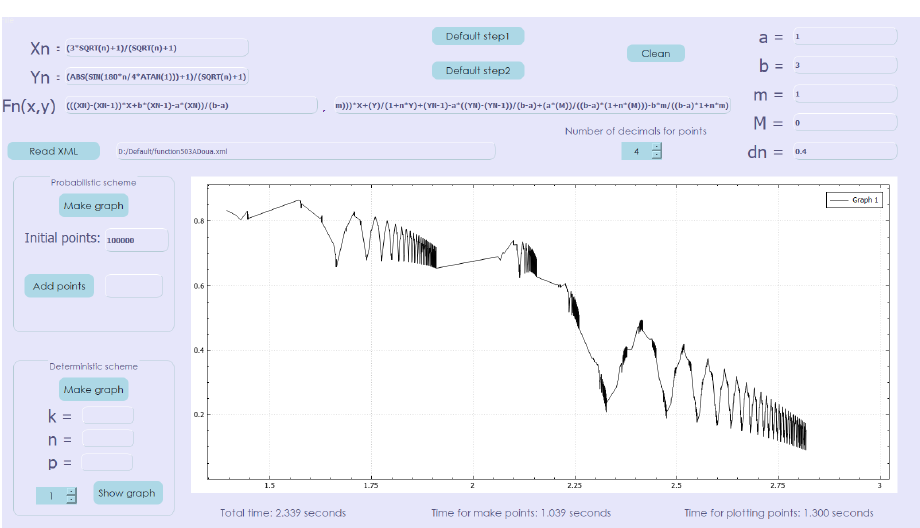
Figure 2. Non-affine probabilistic interpolation scheme (approximation with 100,000